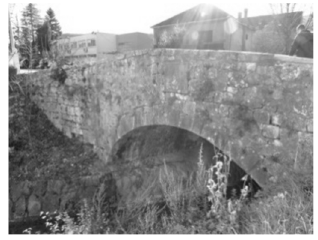
Figure 10. Goru č ica, Sinj (B7). Figure 10. Goruˇcica, Sinj